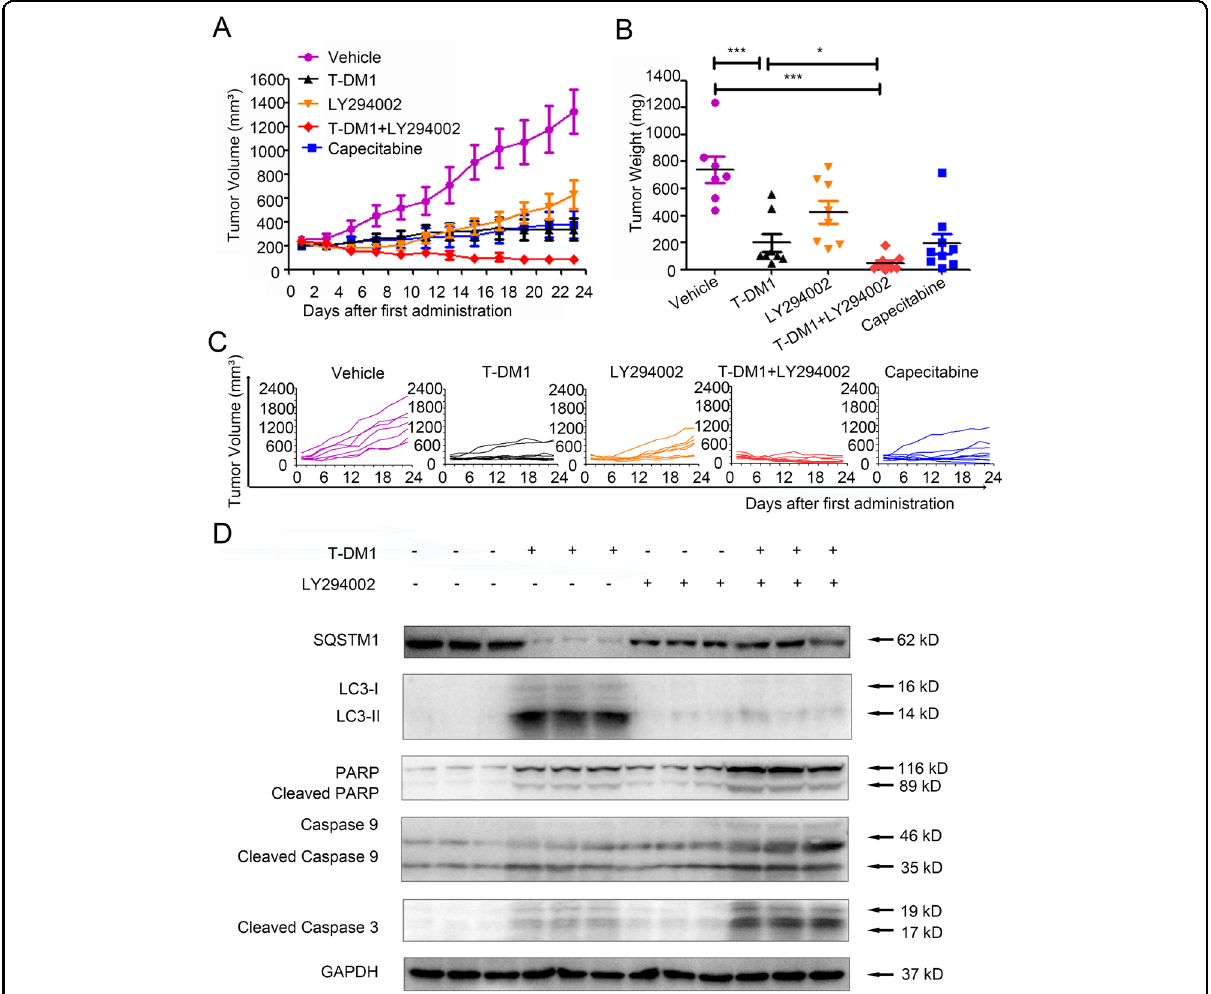
Fig. 5 Inhibiting autophagy enhanced the antitumor ef fi cacy of T-DM1 in vivo. A – C Subcutaneous xenograft models of NCI-N87 cells were established in nude mice. Tumor growth in the different groups was evaluated by caliper measurements and using length × width 2 /2 to calculate tumor volume once every 2 days. Tumor weights were measured after 23 days of intervention, and each point represents an independent data from a mouse. The values of different groups were recorded as the mean ± S.D. The treatment of T-DM1 combined with LY294002 (n = 8) reduced tumor volumes as compared with T-DM1 ( n = 9) or Vehicle ( n = 7), * P < 0.05, and *** P < 0.001. T-DM1 treatment alone reduced tumor volumes as compared with Vehicle, *** P < 0.001. D The levels of SQSTM1, LC3, cleaved PARP, cleaved caspase 9, and cleaved caspase 3 in xenograft tumor tissue were examined by immunoblot analysis. The results of statistical analysis were presented in Supplementary Fig.